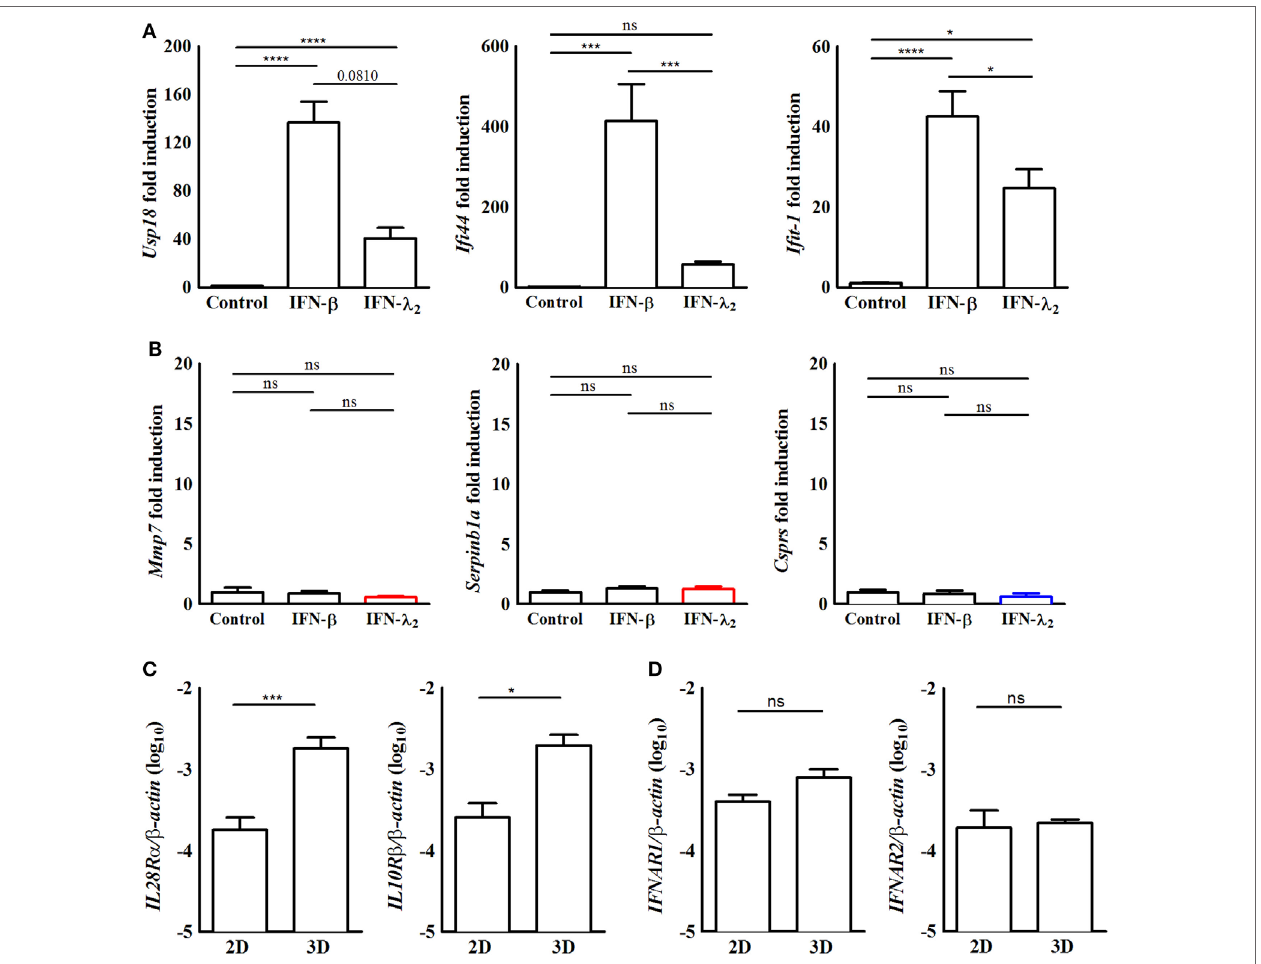
FigUre 2 | The induction of predominantly interferon (IFN)- λ 2 -induced genes requires epithelial polarization. (a,b) Quantitative RT-PCR for (a) the prototypical IFN-stimulated genes (ISGs) Usp18 , I fi44 , and Ifit1 or (b) the predominantly IFN- λ -induced ISGs Mmp7 , Serpinb1a , and Csprs performed on total RNA isolated from IEC10 cells grown in conventional flat bottom 12-well tissue culture plates under 2D conditions and stimulated for 9 h with IFN- λ 2 (20 ng/mL) or IFN- β (500 U/mL). The results represent the mean ± SEM values from two independent experiments and are normalized to the values obtained for the housekeeping gene β -actin . Statistical significance was calculated using a one-way analysis of variance (with Tukey’s posttest). (c,D) Quantitative RT-PCR for (c) IL-28R α and IL-10 receptor (IL-10R) β and (D) IFNAR1 and IFNAR2 performed on total RNA isolated from unstimulated IEC10 cells grown either on conventional flat bottom tissue culture plates (2D) or transwell inserts (3D). The results are normalized to the values obtained for β -actin and are represented as mean ± SEM values from two independent experiments performed in quadruplicates. Statistical significance was calculated using the Mann–Whitney U